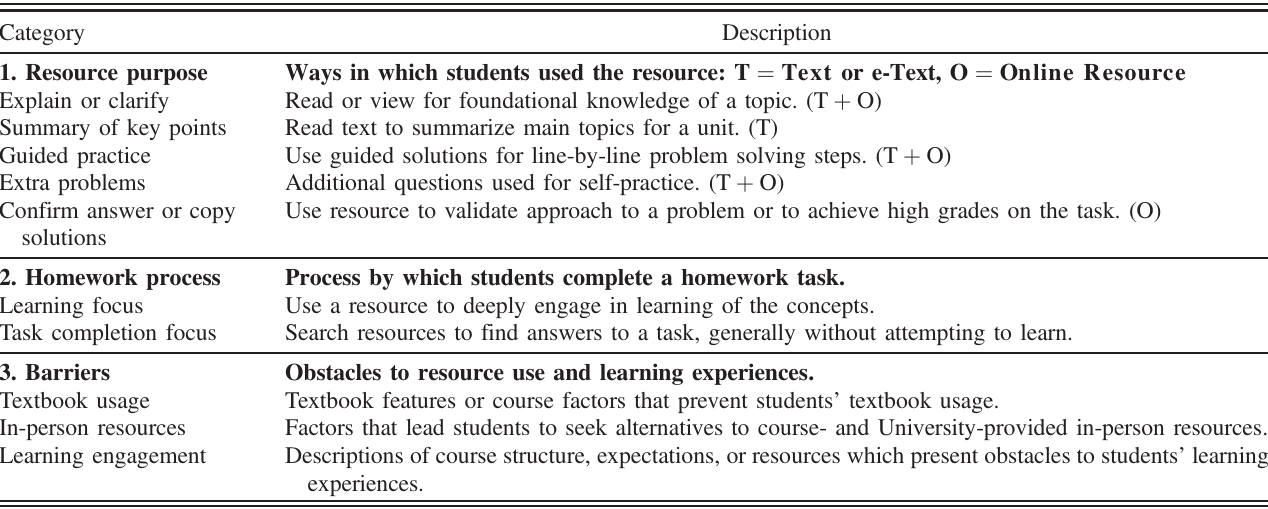
TABLE I. Interview coding